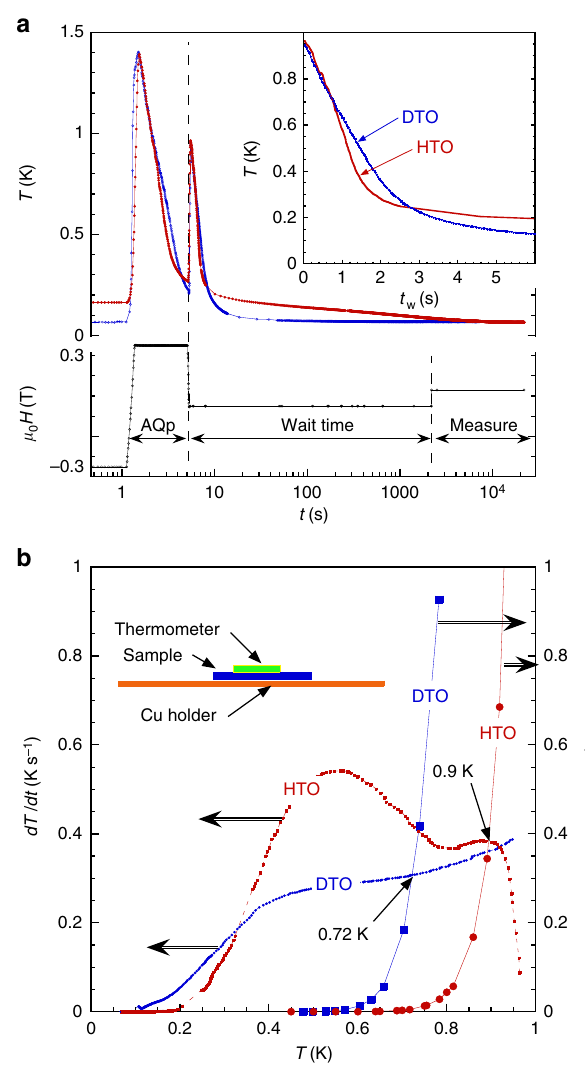
Fig. 2 Controlled cooling of spin ice below its freezing temperature. How the temperature of the samples varies during and after the AQP: a The applied fi eld (black) during an AQP, and the temperatures measured by a small thermometer glued directly on top of the samples (schematically shown in ( b )) vs. log time for Ho 2 Ti 2 O 7 (HTO, red) and nat Dy 2 Ti 2 O 7 (DTO, blue). The inset shows a zoom of the fi rst 6 s vs. time. b Comparison of the sample cooling rates dT / dt as a function of temperature after the AQP for Ho 2 Ti 2 O 7 and nat Dy 2 Ti 2 O 7 from the data in ( a ) to the equilibrium cooling rate dT / d τ extracted from ac susceptibility data for the two samples (see Supplementary Fig. 6). The cooling rate for Ho 2 Ti 2 O 7 crosses the equilibrium rate at ~0.9 K, and nat Dy 2 Ti 2 O 7 at 0.72